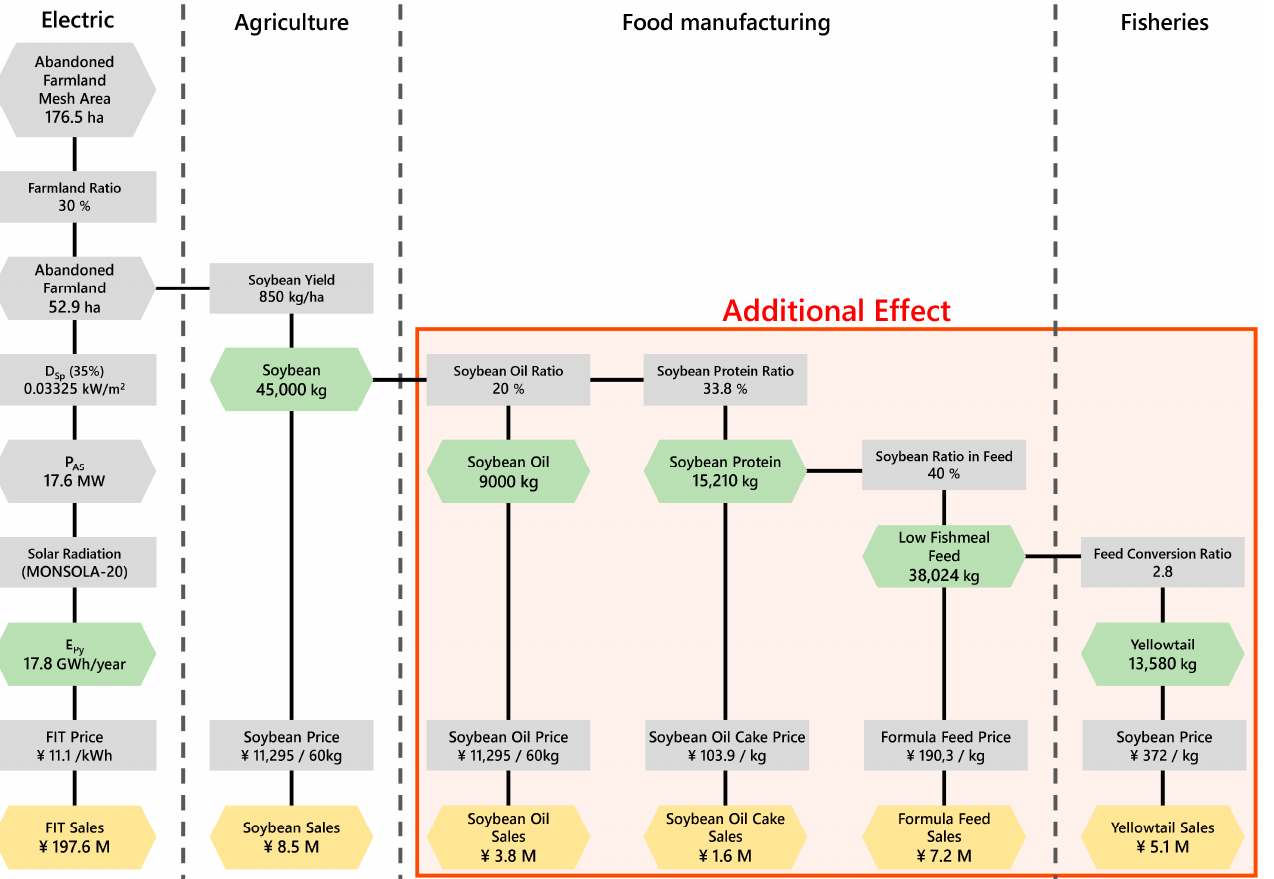
Figure 7. Annual AVS-related production and revenues.